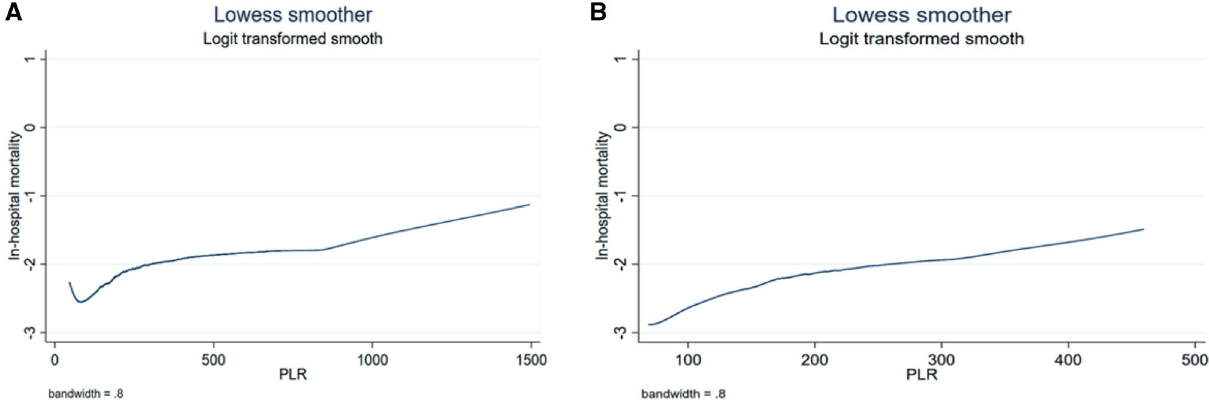
Figure 2. ( A ) Association between PLR and in-hospital mortality presented through Lowess smoothing. ( B ) Association between a range of 10 to 90 percent of PLR and in-hospital mortality presented through Lowess smoothing. Abbreviation: PLR: platelet-lymphocyte